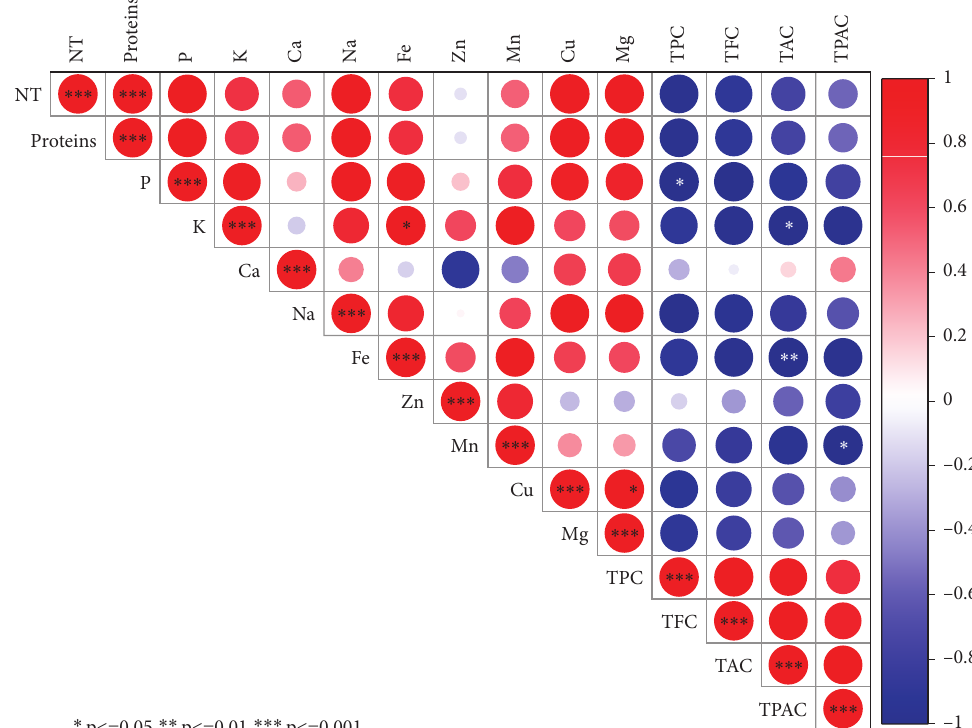
Figure 2: Correlation heatmap showing the relationship between mineral elements and phenolic components. Table 3: FTIR peaks assignments for functional groups found in the spectrum of fig seeds.